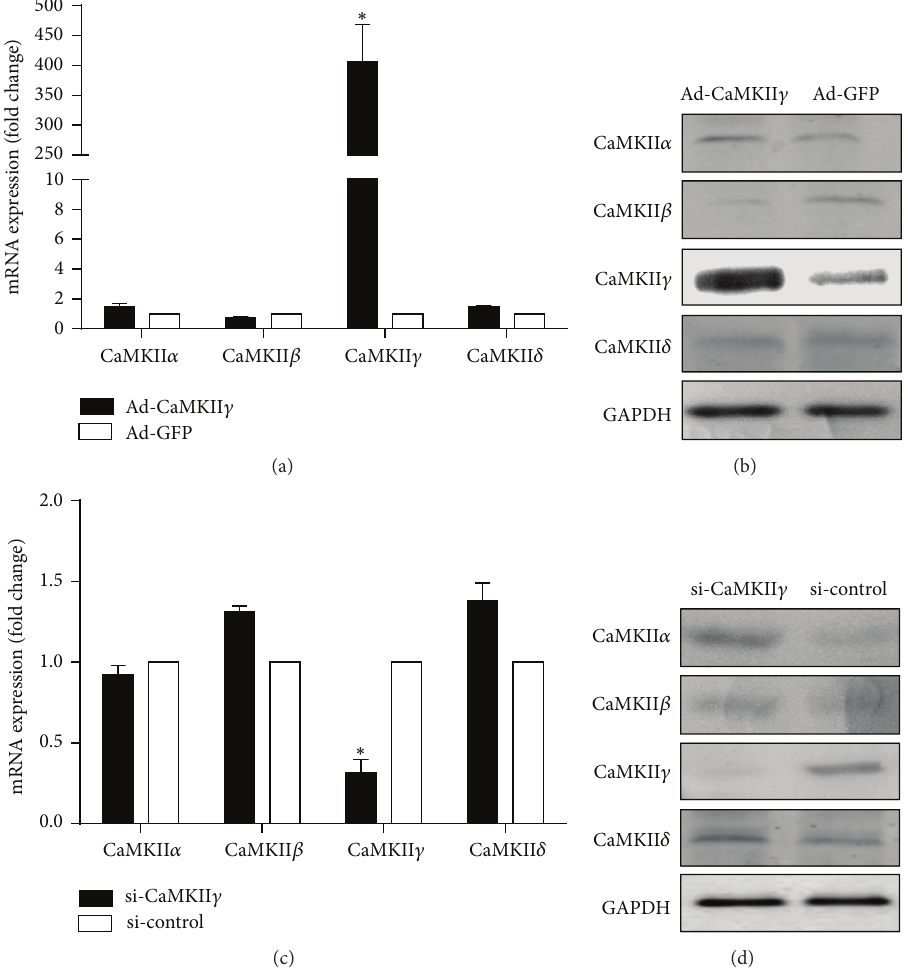
Figure 3: Cell transfection efficiency. CaMKII mRNA (a) and protein (b) expression levels in hASCs transfected with CaMKII 𝛾 and control. (c) qRT-PCR analysis of CaMKII 𝛼 , CaMKII 𝛽 , CaMKII 𝛾 , and CaMKII 𝛿 in hASCs transfected with siRNA targeting CaMKII 𝛾 (si-CaMKII 𝛾 ) and nontargeting siRNA (si-control) for 48 hours, respectively. (d) Detection of CaMKII isoforms by western blot in hASCs transfected with siRNA targeting CaMKII 𝛾 (si-CaMKII 𝛾 ) and nontargeting siRNA (si-control). ∗ 𝑃 < 0.05 when (a) versus ad-GFP and (c)